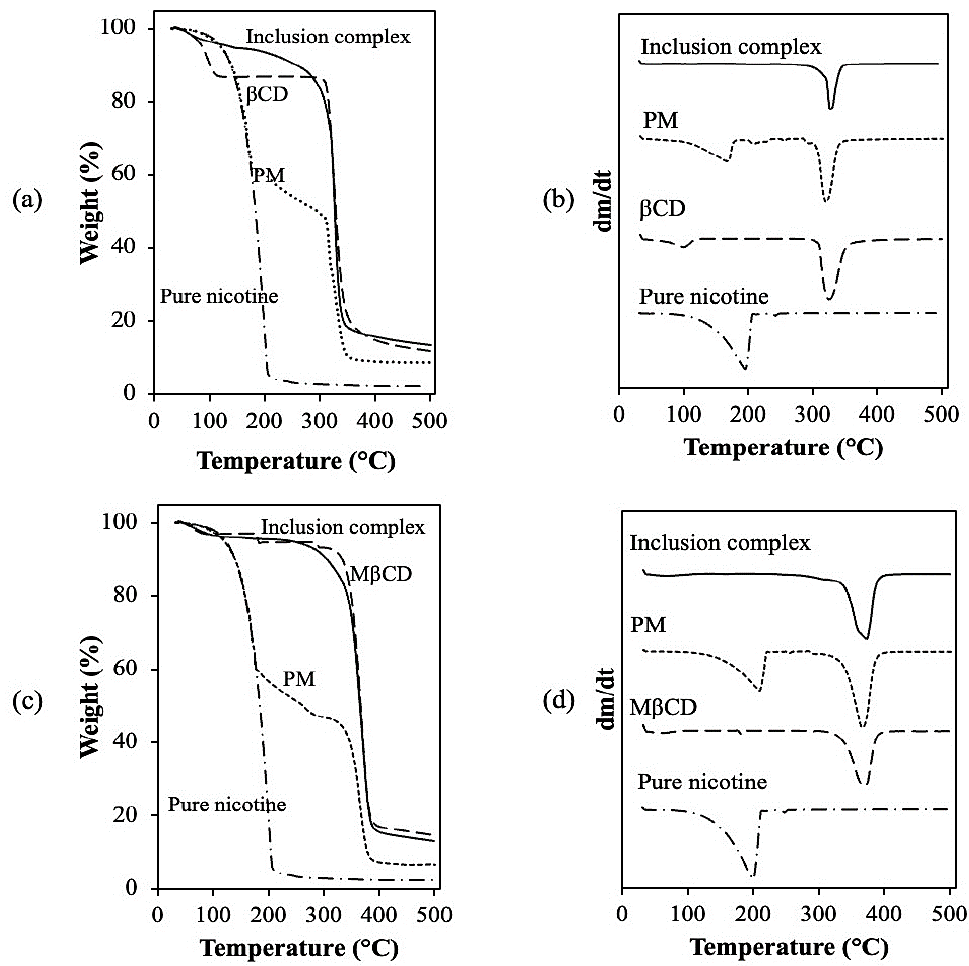
Figure 5. Thermal analysis curves of the inclusion complexes; ( a ) TG and ( b ) DTG curves of nicotine/ β CD and ( c ) TG and ( d ) DTG curves of nicotine/M β CD.